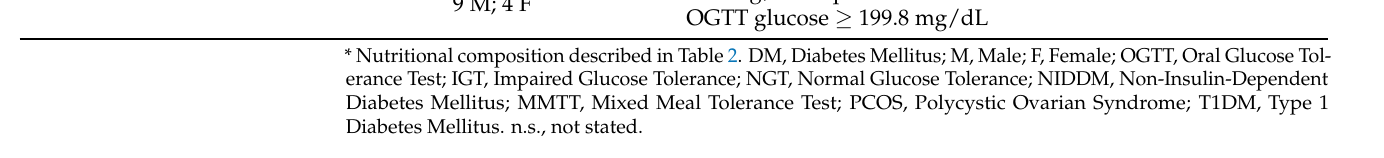
Table 2. Nutritional characteristics of the products and/or meals